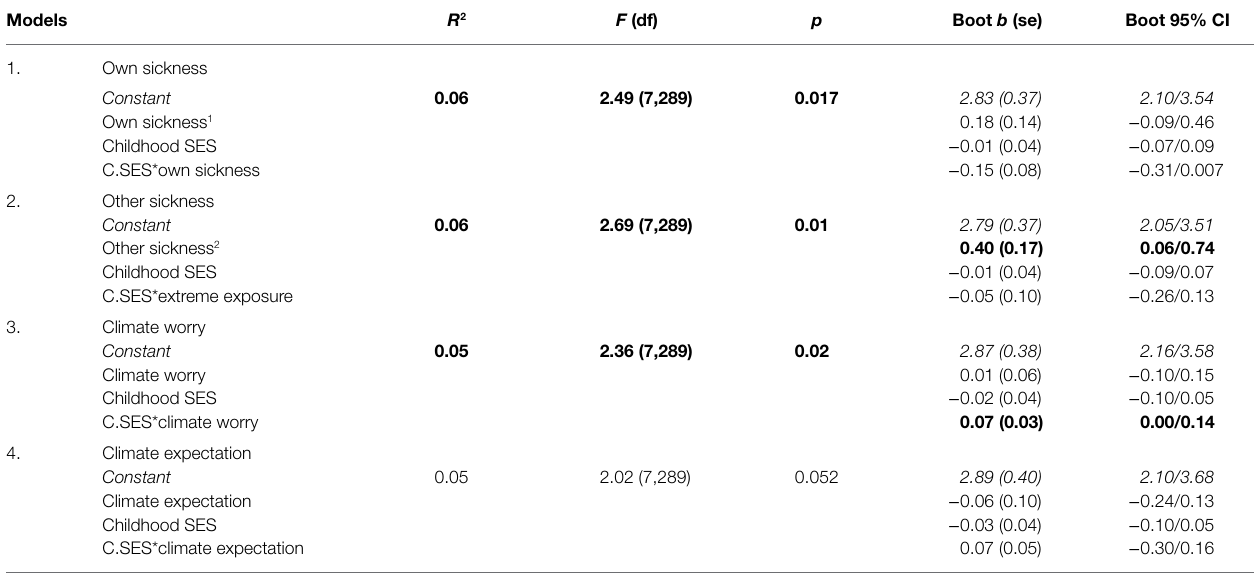
TABLE 3 | Moderating effect of childhood SES on ideal number of